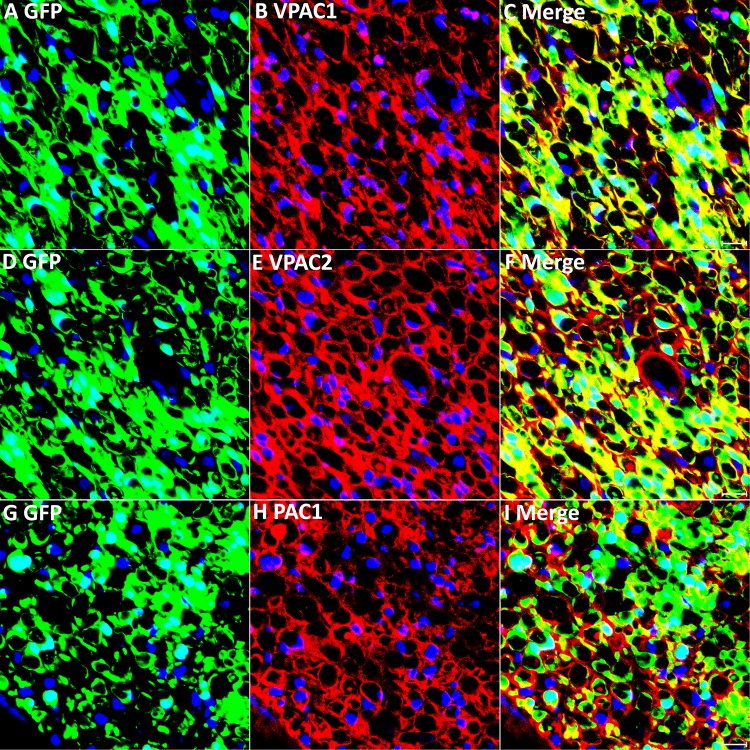
VPAC1, VPAC2, and PAC1 expression in Schwann cells of the distal nerve stump following injury. VPAC1, VPAC2, and PAC1 staining on transverse sections from distal sciatic nerve of PLP-GFP mice 7 days after transection injury. VPAC1 (A–C), VPAC2 (D–F), and PAC1 (G–I) all co-localize with GFP in Schwann cells, confirming that VPAC1, VPAC2, and PAC1 are all expressed in Schwann cells of the distal nerve stump. Scale bars in (C,F,I) 20 μm. Three mice were used and three sections from each mouse were stained for each receptor.